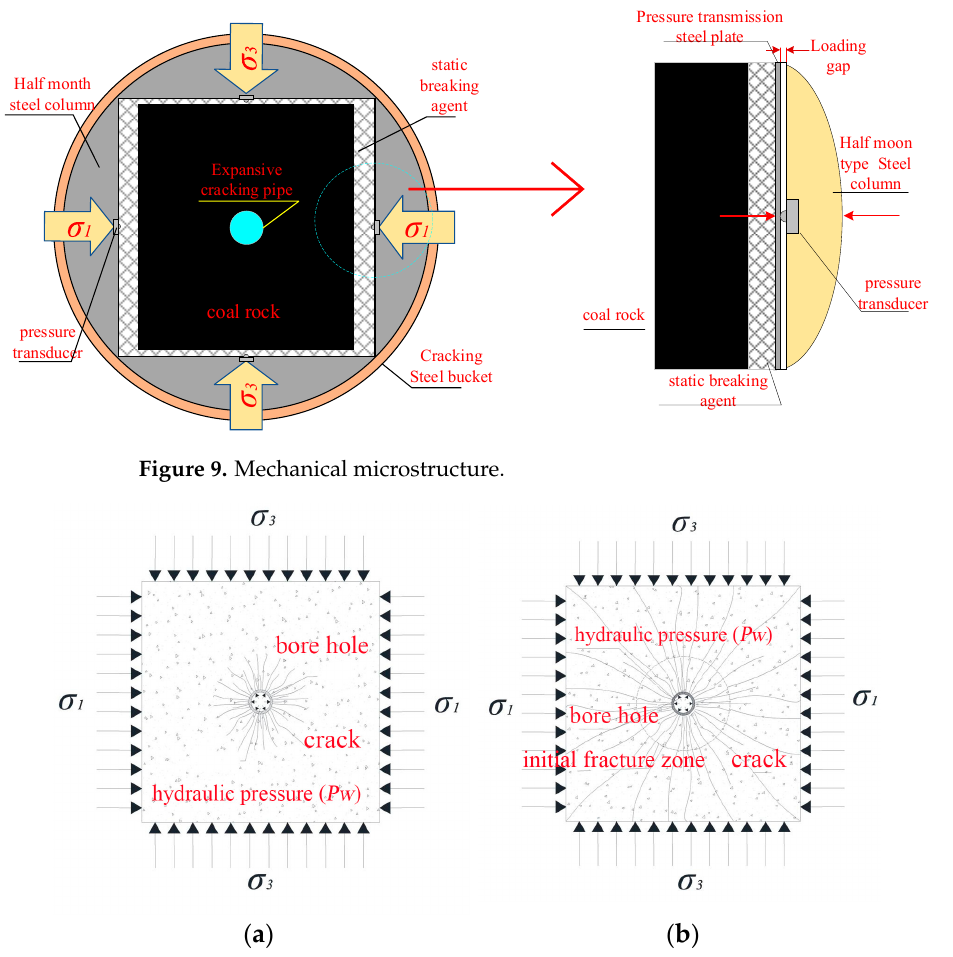
Figure 10. Schematic diagram of coal and rock mass cracking step by step under cyclic load. ( a ) Initial fracturing; ( b ) Extended fracturing.